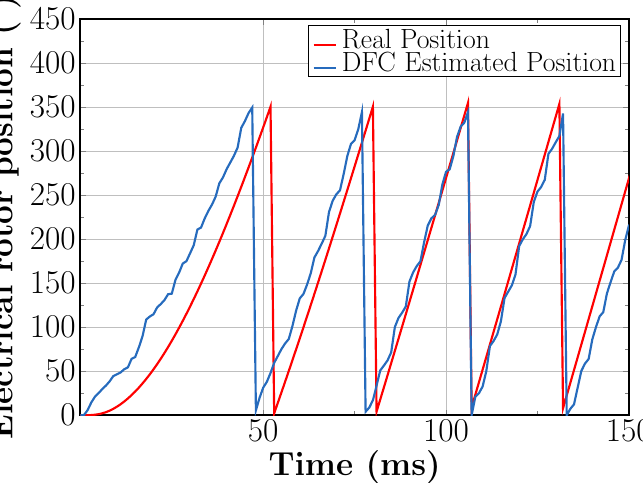
Figure 16. Sensorless speed control for 1200 RPM, real electrical rotor position and DFC estimated rotor position.